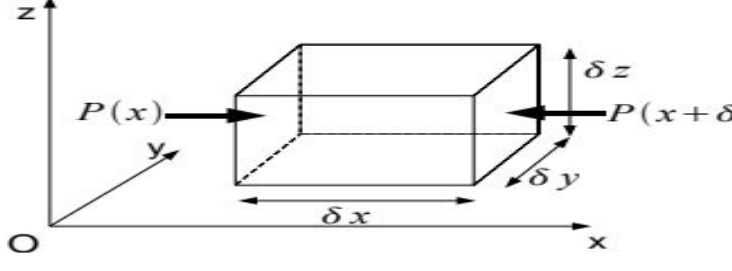
Figure 8. Pressure forces (following ( Ox )) on a plot.